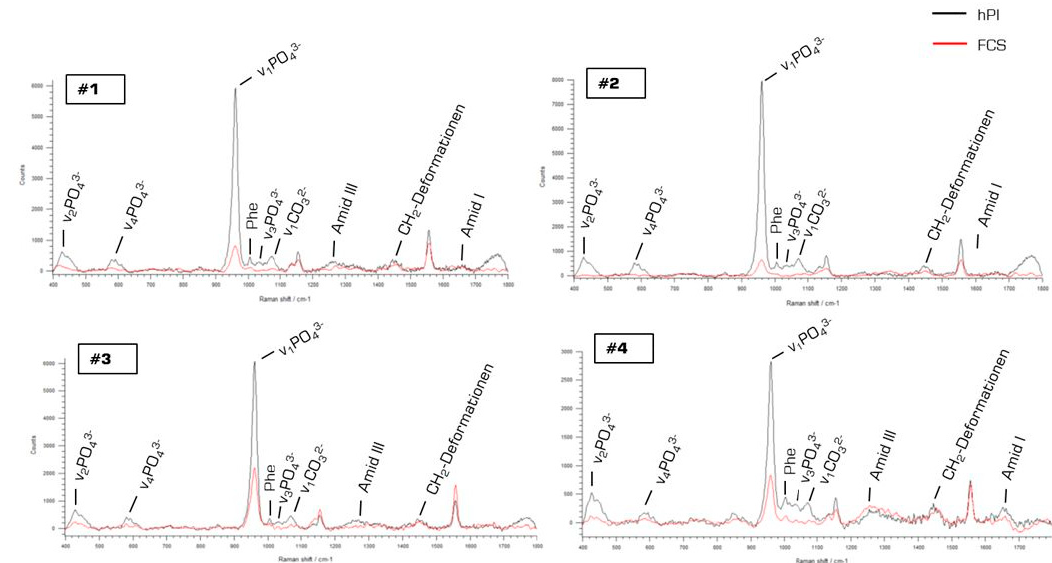
Figure 5. Mean Raman spectra from hPL- and FCS-supplemented JPCs. Mean Raman spectra from four donors (#1, #2, #3, #4) generated from JPCs growing in Raman glass dishes under hPL (black spectra) and FCS (red spectra) supplementation. Abbreviations: FCS—fetal calf serum, hPL—human platelet lysate.